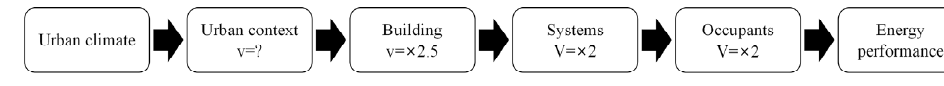
Figure 3. Factors that affect building energy consumption